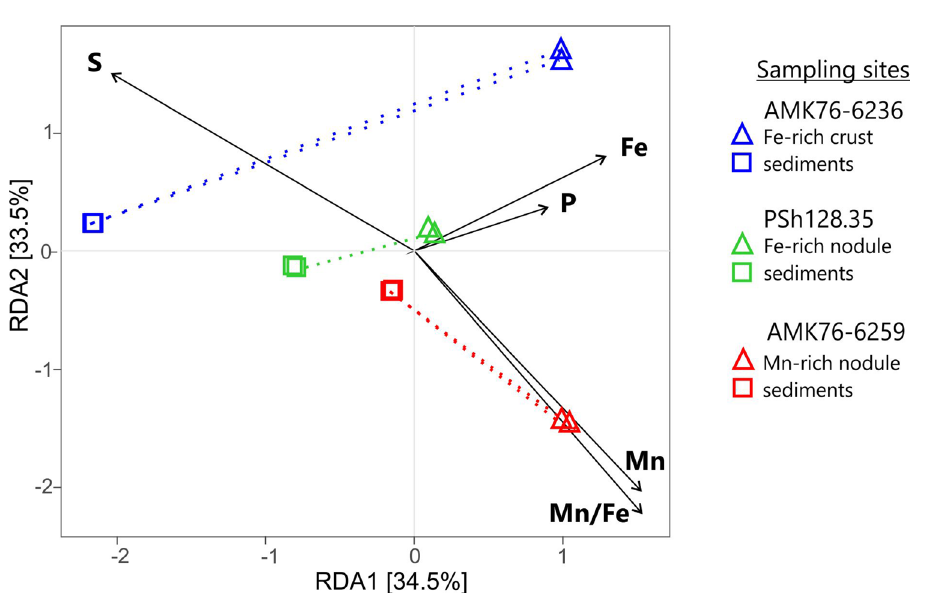
Figure 6. Redundancy analysis (RDA) showing the relationships between the compositions of major elements and microbial communities identified in the samples of Fe–Mn nodules, crust and underlying sediments. For visualization of RDA, the Rstudio software (R version 4.1.0) and microeco package were applied 77–79